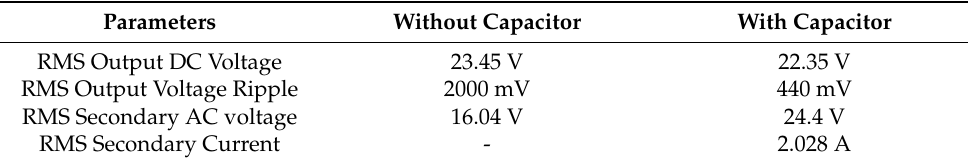
Table 1. Effect of output capacitor on various parameters.